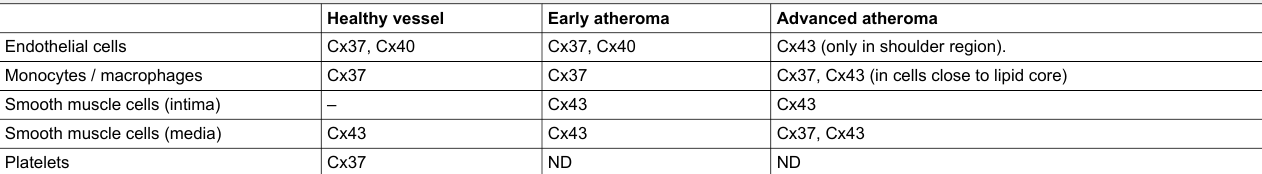
Table 1: Expression of connexons during atherosclerotic plaque development. ND: not determined. Healthy vessel Early atheroma Advanced atheroma Endothelial cells Cx37, Cx40 Cx37,